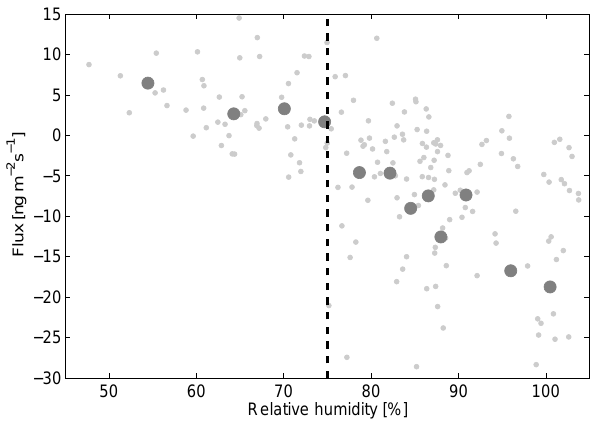
Figure 9. Temperature and PPFD classified ( T ≤ 15 ◦ C and PPFD ≤ 50µmolm − 2 s − 1 ) methanol fluxes (grey dots) as a func- tion of relative humidity (June–August, years 2010–2013). The grey circles are bin median fluxes ( n = 15) and the dashed line represents the threshold value RH 0 = 75% (Eq. 14).